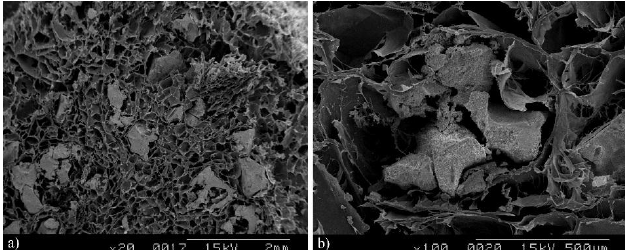
Figure 1. SEM structure of hydroxyapatite/β-tricalcium (HA/β-TCP) phosphate-collagen composite. The scanning electron microscope photograph showed the HA/β-TCP granules to be homogenous ( a ) (magnification 20×) and integrated in the collagen matrix ( b ) (magnification 100× ) .